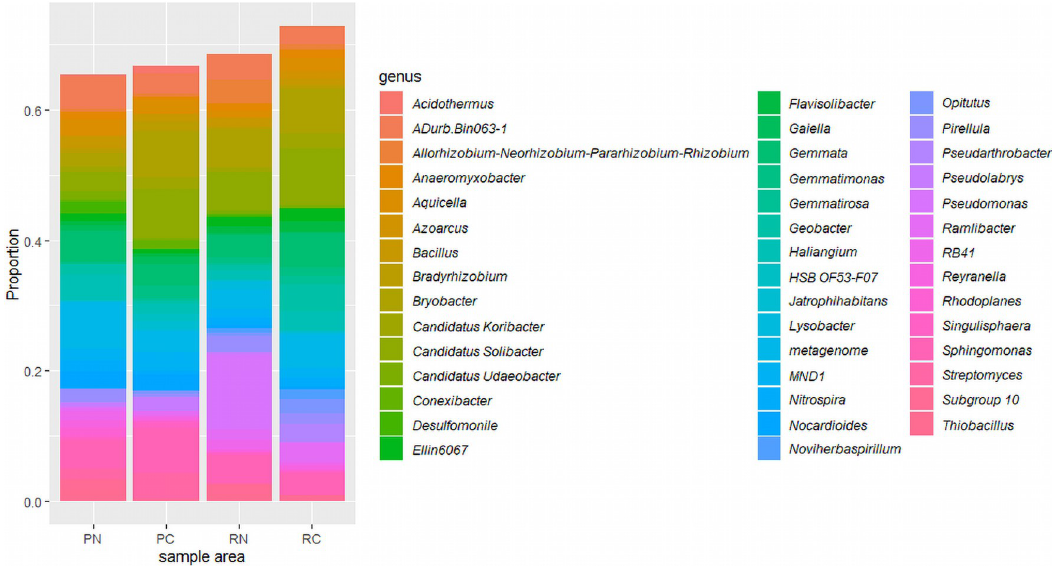
Fig 2. Relative abundance ( > 1%) of the dominant bacteria at the genus level. PN, Nantou polluted area; PC, Changhua polluted area; RN, Nantou remediated area; RC, Changhua remediated area.